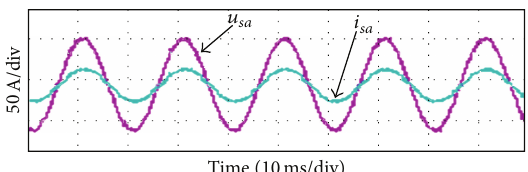
Figure 13: Waves of power grid voltage and current after compen- sation (resistor-inductor